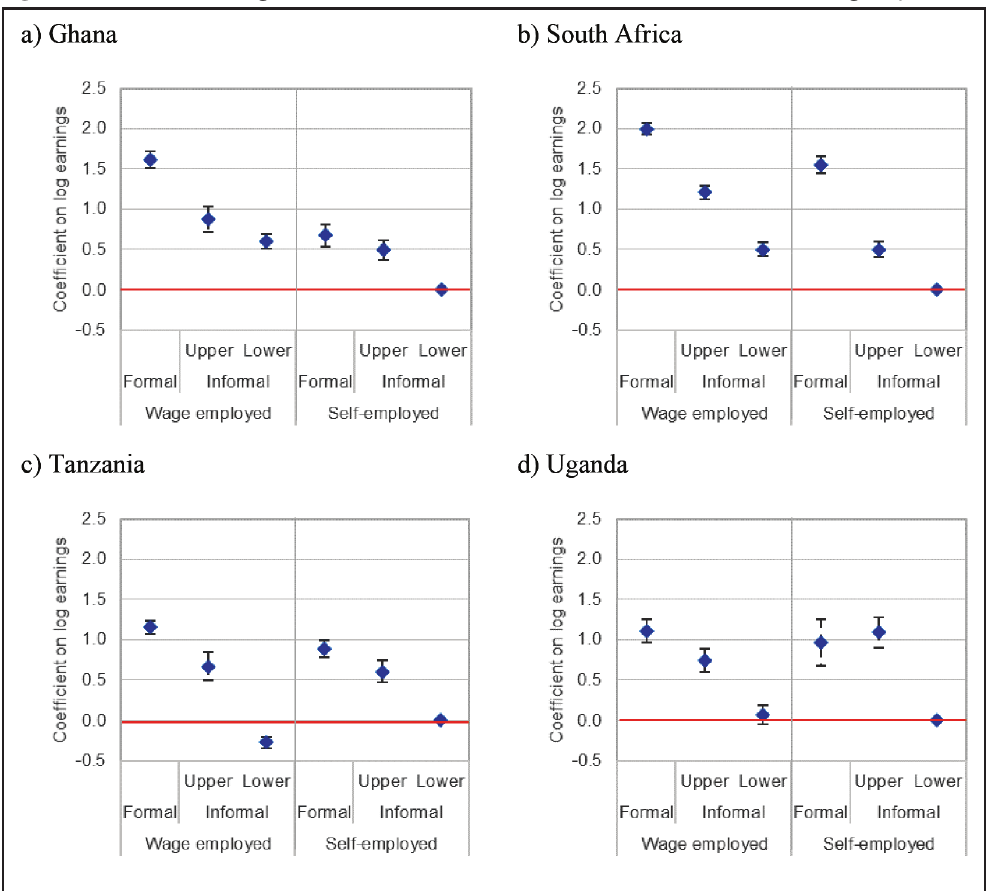
ANOVA of log mean labor income (in 2005 PPPs) across work status